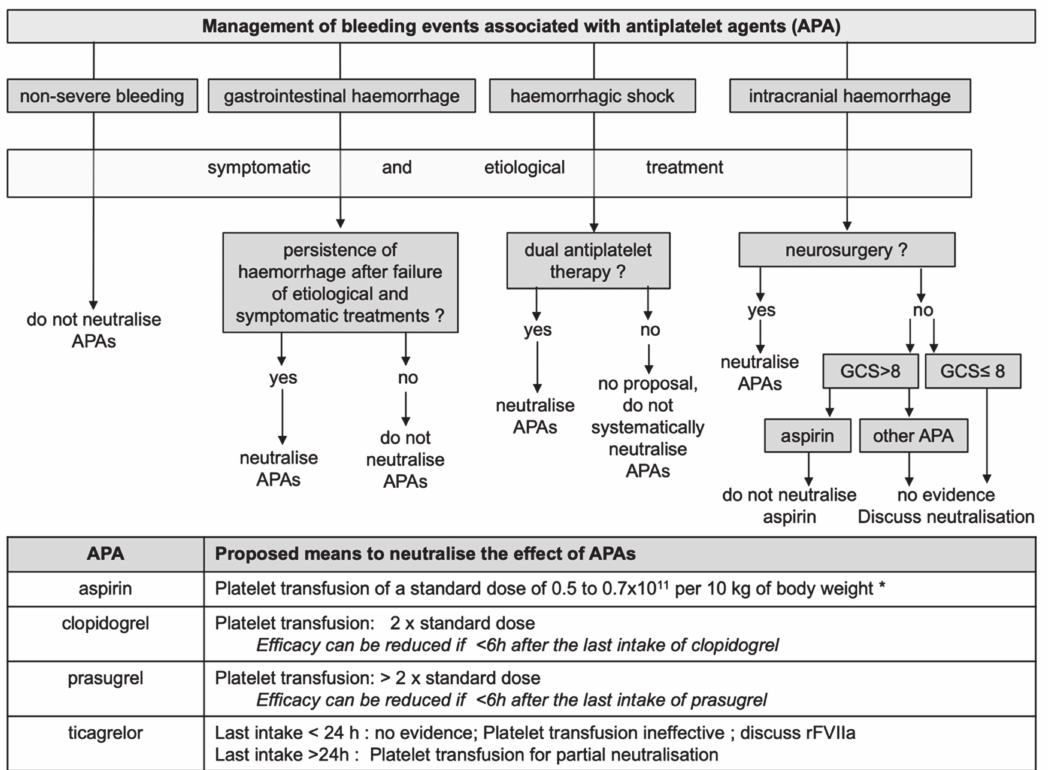
Figure 1. Management of bleeding events associated with antiplatelet